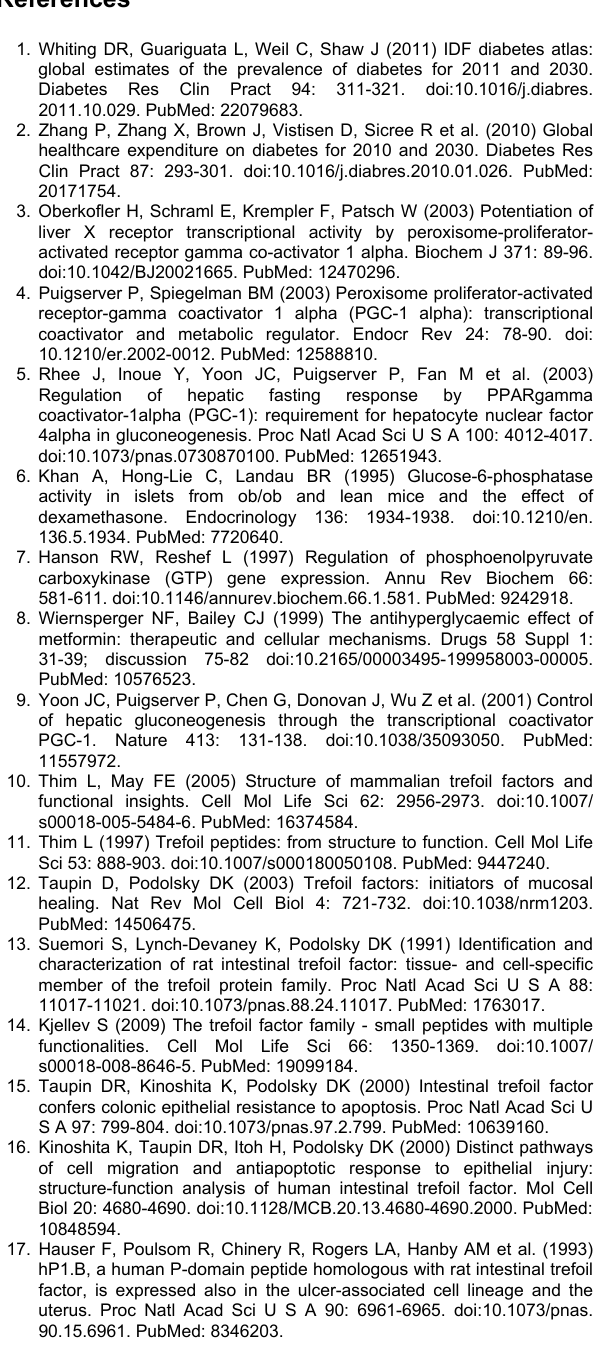
Table S1. Primer used in real-time